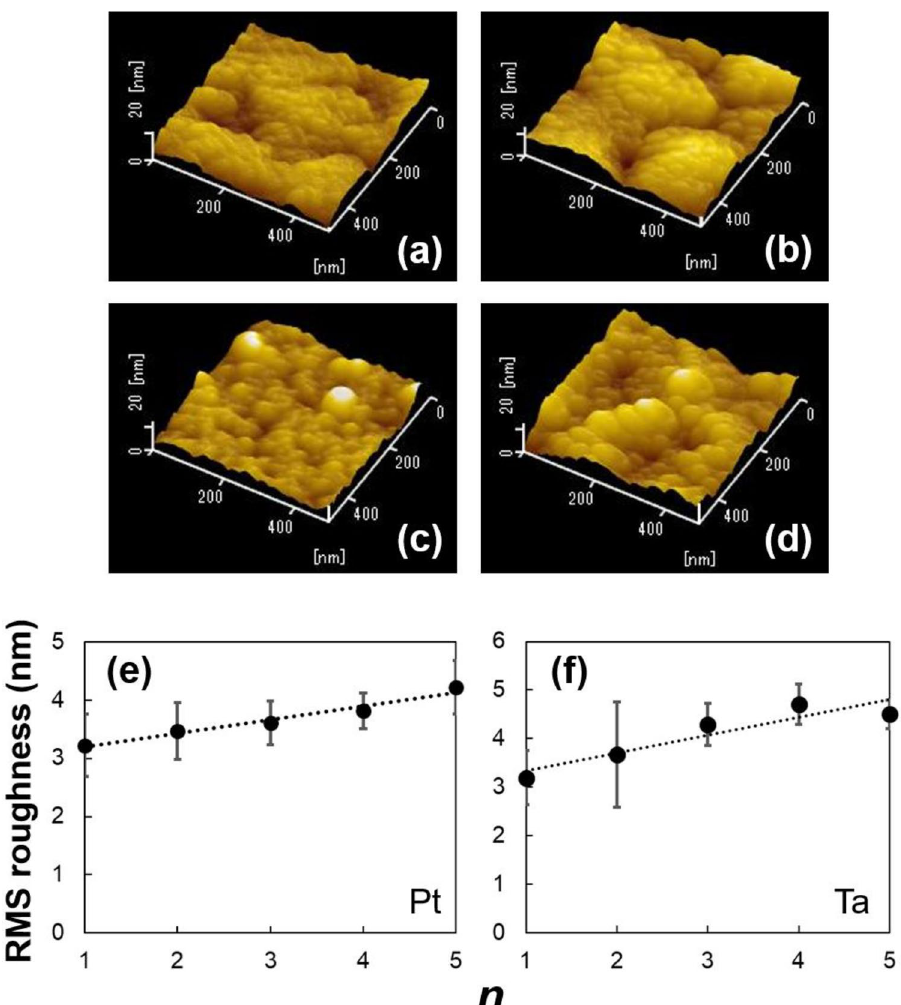
Figure 5. AFM images of the [Pt film/Fe 3 O 4 nanoparticle] n films with ( a ) n = 1 and ( b ) n = 5, and the [Ta film/ Fe 3 O 4 nanoparticle] n films with ( c ) n = 1 and ( d ) n = 5 on the polyimide sheet annealed at T A = 473 K. Root mean square roughness as a function of number of stacking n for Fe 3 O 4 nanoparticle-assembled films with ( e ) Pt and ( f ) Ta layers. The black dash lines were estimated by least-squares